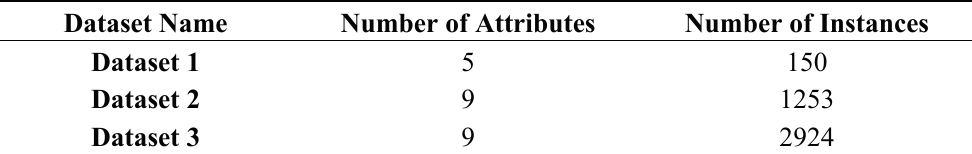
Table 2. Dataset collected for running time.